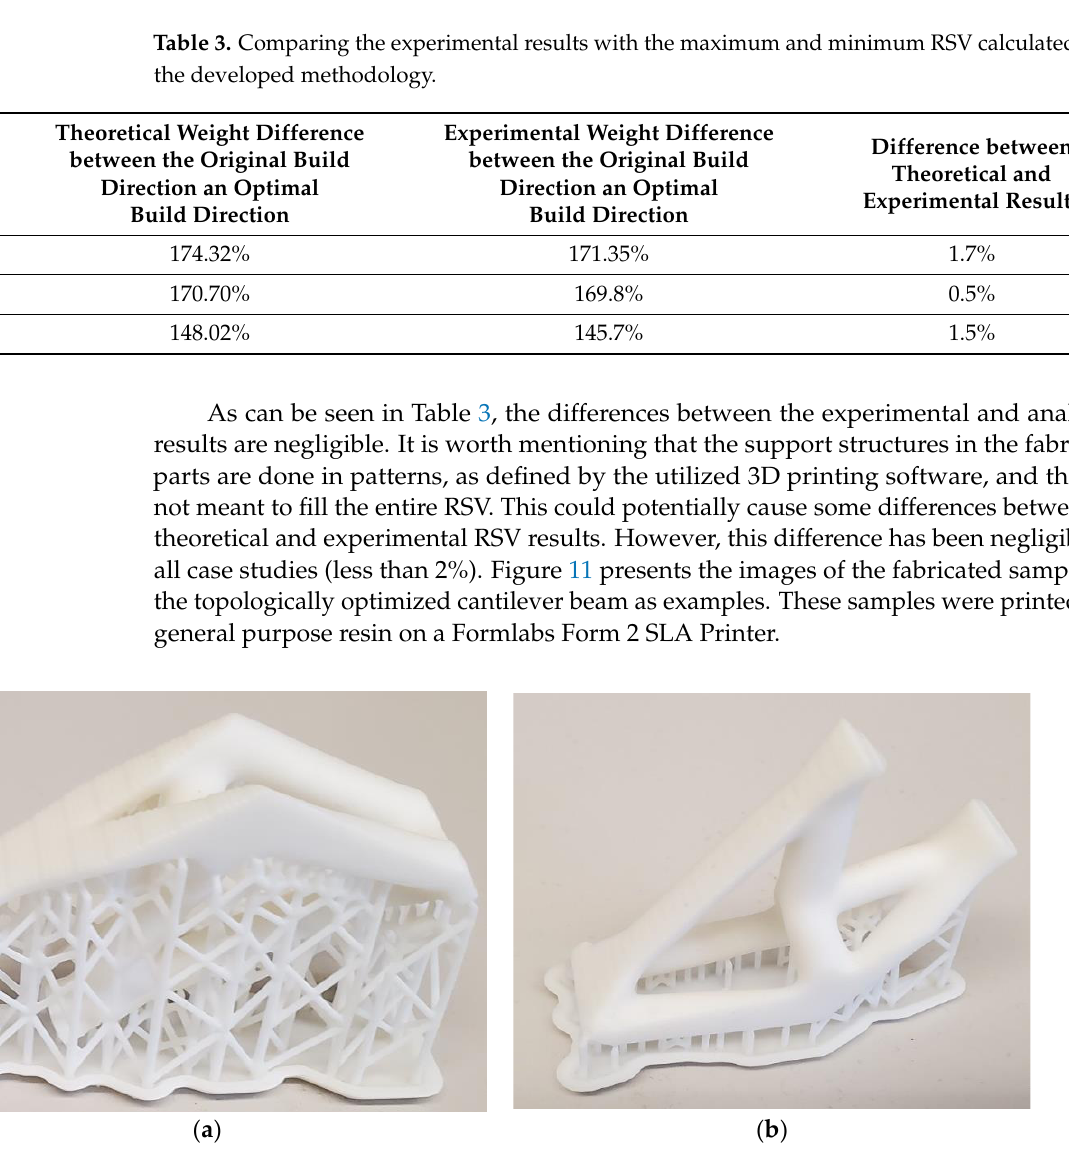
Figure 11. Examples of the fabricated samples for the experimental topologically optimized canti- lever beam: ( a ) orientation with maximum required support volume; and ( b ) orientation with min- imum required support volume. required support Table 3. Comparing the experimental results with the maximum and minimum RSV calculated us- ing the developed methodology.